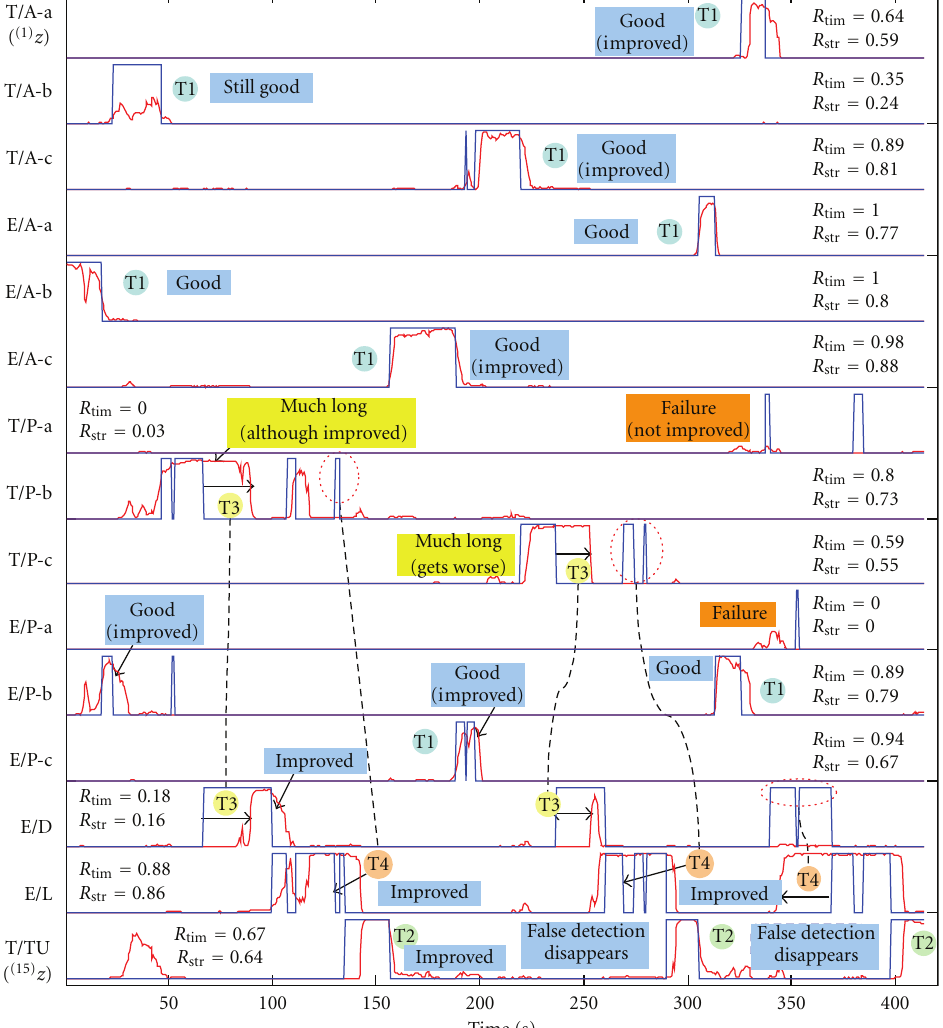
Figure 15: Transitions of intentions: red lines were identified by the SOM-Bayes estimator using scalar ρ . Blue lines were discerned by human